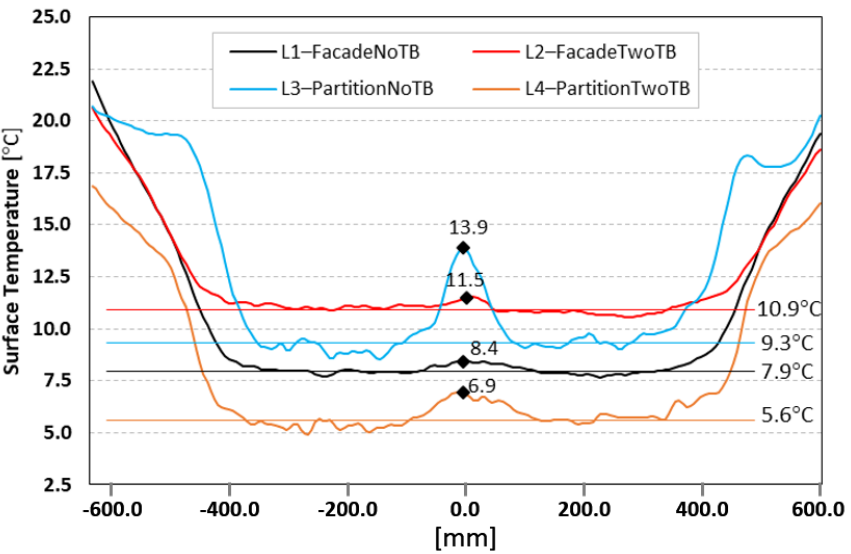
Figure 10. Cold surface temperatures along horizontal lines obtained from thermographic images of the measured facade and partition LSF walls, with and without thermal break (TB) strips made from aerogel.